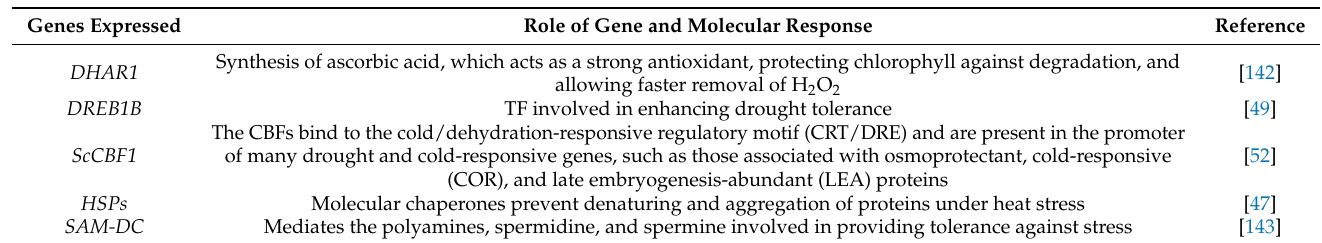
Table 2. Role of the different genes influencing various traits during the process of